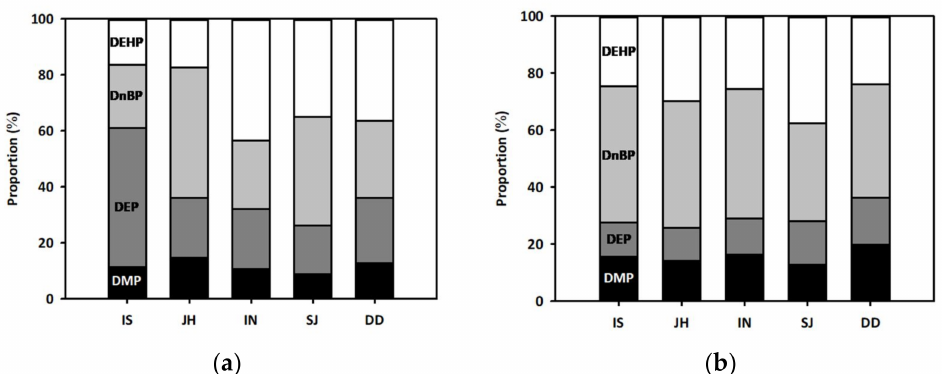
Figure 3. Proportions of phthalate esters (PEs) in the seawater of five beaches in South Korea in; ( a ) Spring, and ( b ) Summer in 2017. IS—Ilsan Beach; JH—Jinha Beach; IN—Imnang Beach;